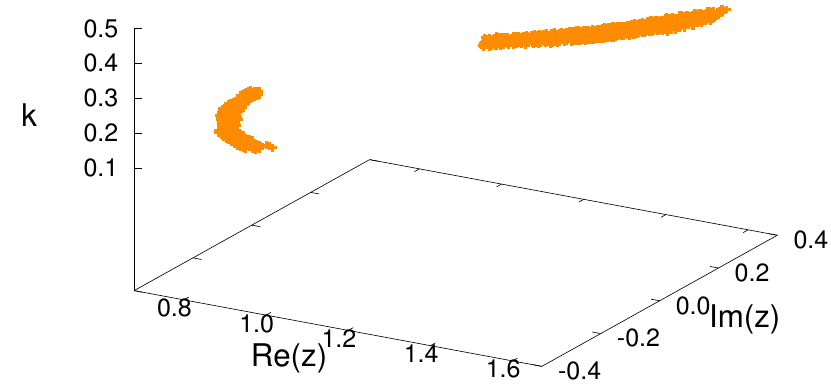
Figure 4 . 3D parameter space after getting second round of restriction by the requirement of positive baryon